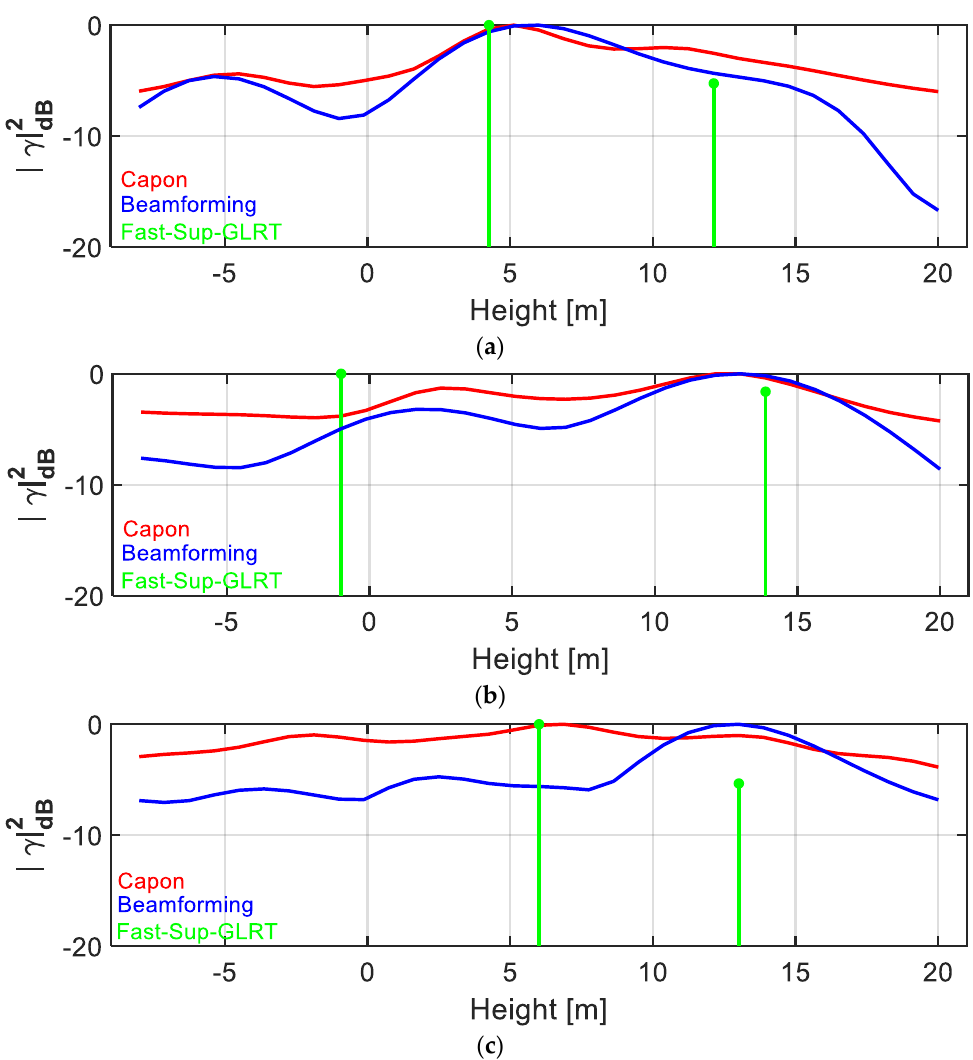
Figure 9. Reflectivity profile obtained with beamforming (blue), Capon (red), Fast-Sup-GLRT (green), in correspondence of the three double scatterers in line C, respectively in (a), (b) and (c).